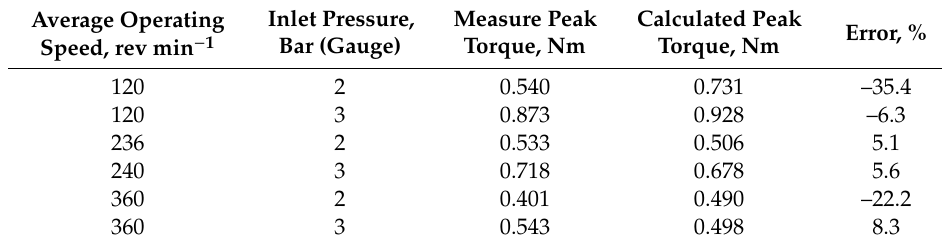
Table 3. Peak Torque